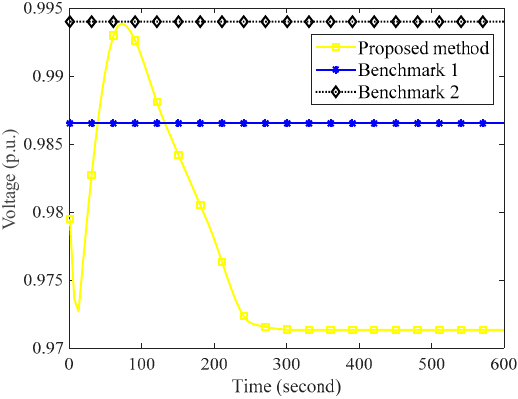
Figure 5. The cost function value.